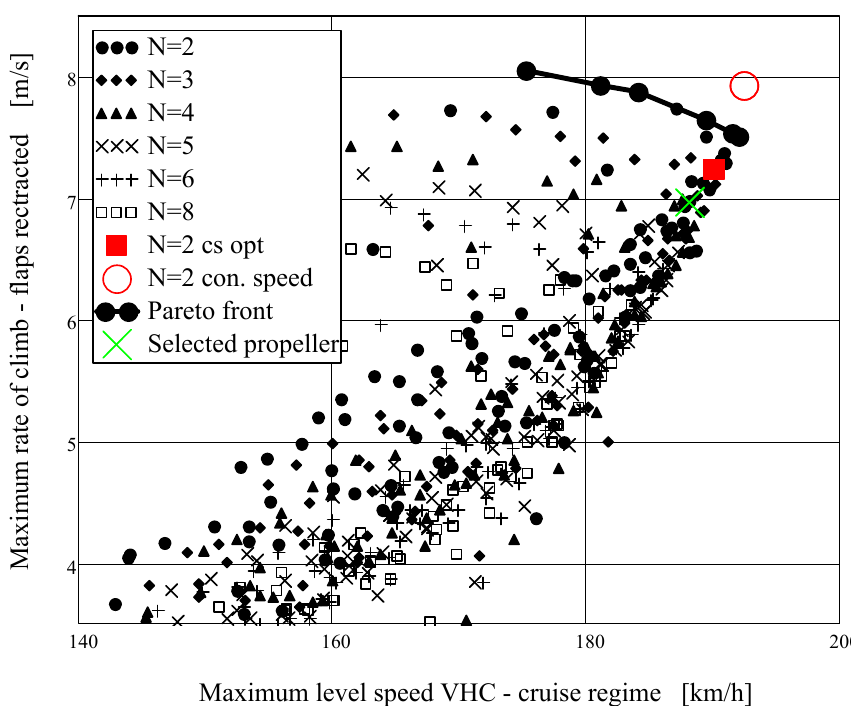
Figure 9. Pareto front for maximum horizontal flight speed, (cruise engine regime) and maximum rate of climb (take-off engine regime). Table 4. Points on the Pareto front for maximum horizontal speed (cruise engine regime) and maximum rate of climb (see Figure 9).